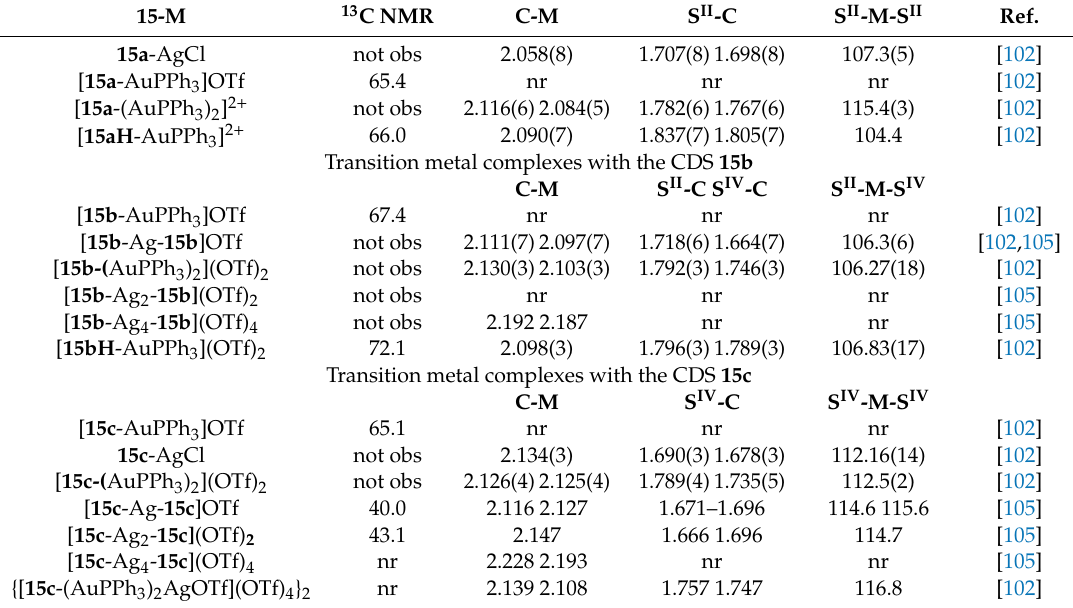
Table 12. Transition metal complexes with selected bond length (Å) and angles (deg) of the